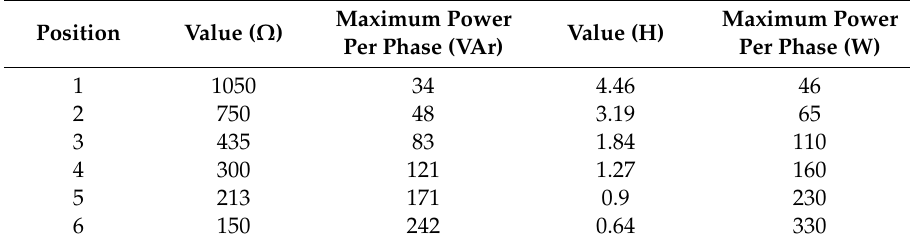
Table 5. Resistor and Inductances